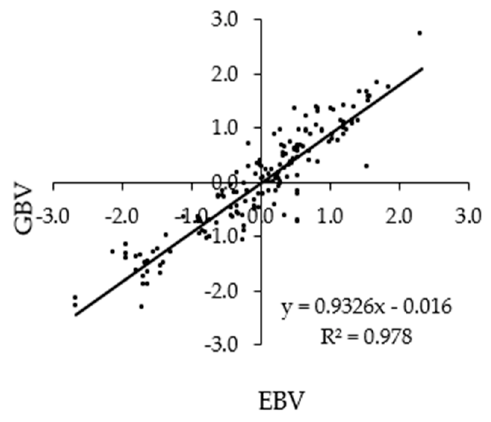
268 268 279 276 280